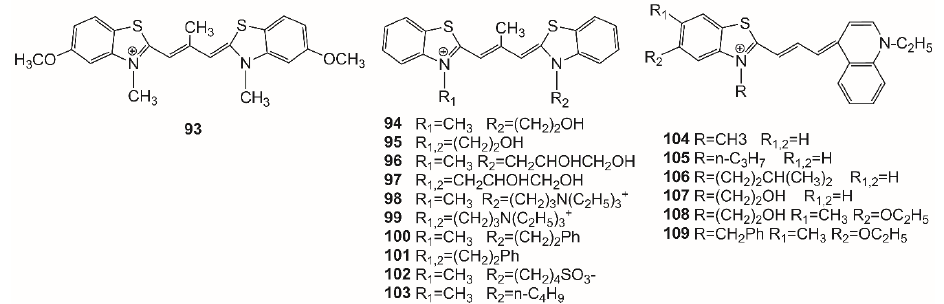
Figure 20. Structures of trimethine cyanines 93–109.